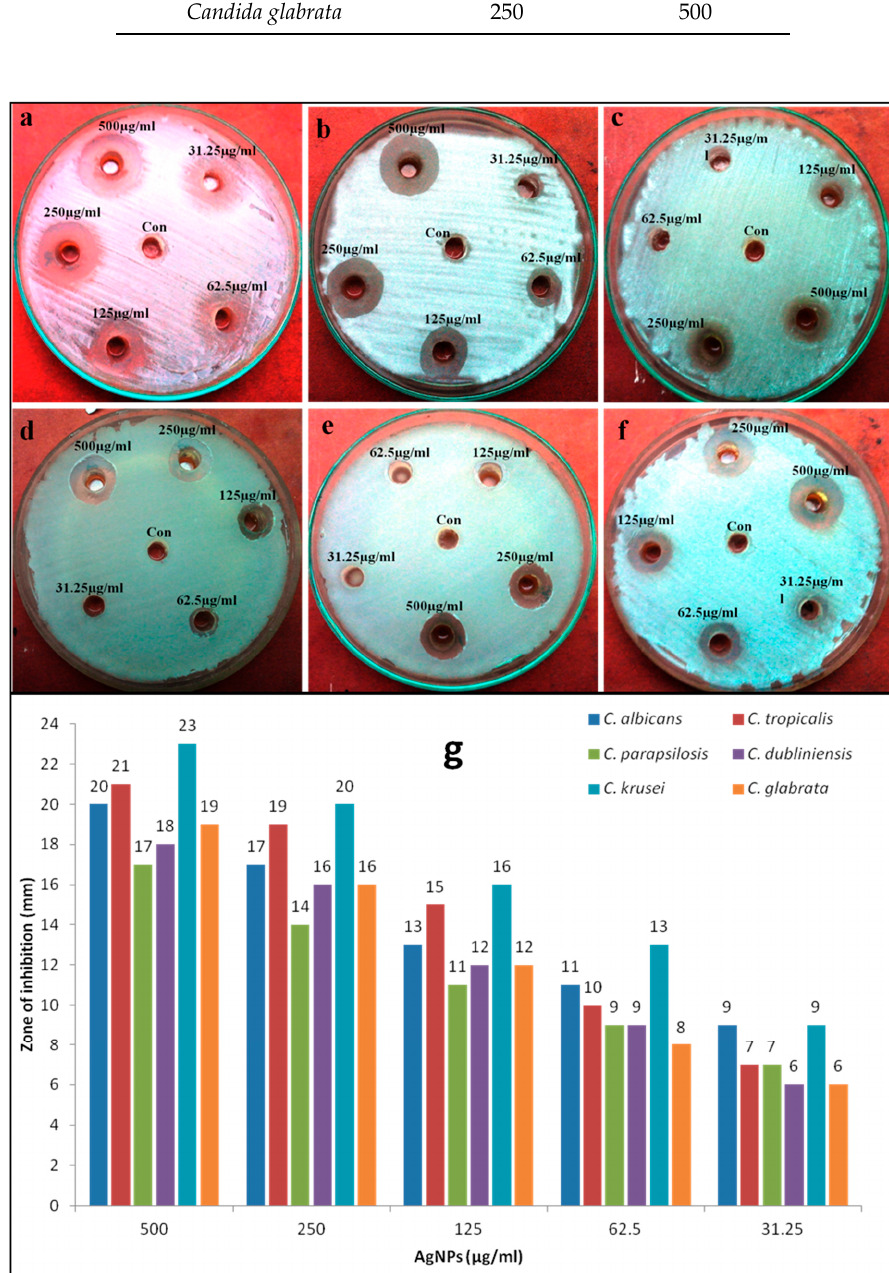
Figure 5. Anticandidal activity of mycosynthesized AgNPs at different concentrations evaluated by agar well diffusion method against different Candida spp.: ( a ) C. albicans , ( b ) C. tropicalis , ( c ) C. dubliniensis , ( d ) C. glabrata , ( e ) C. parapsilosis , and ( f ) C. krusei . Panel ( g ) represents the zone of inhibition (in mm) at different concentrations of AgNPs.